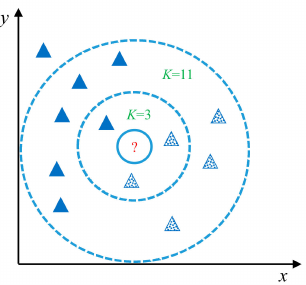
Figure 2. Demonstration of the K -nearest neighbors (KNN) method.